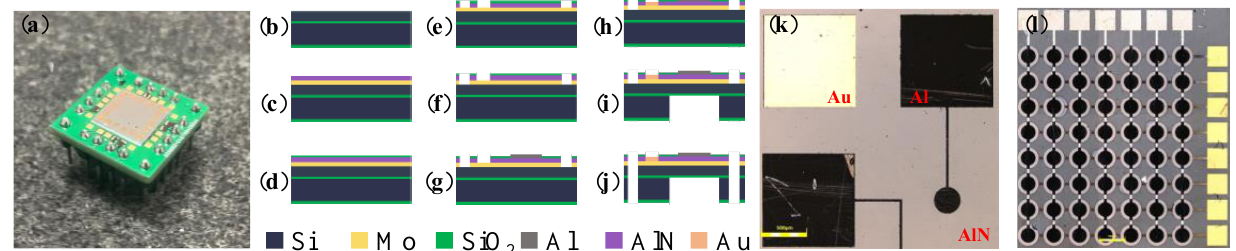
Figure 2. ( a ) PMUT device; ( b – j ) MEMS process flow; ( k ) PMUT cell; ( l ) PMUT array.